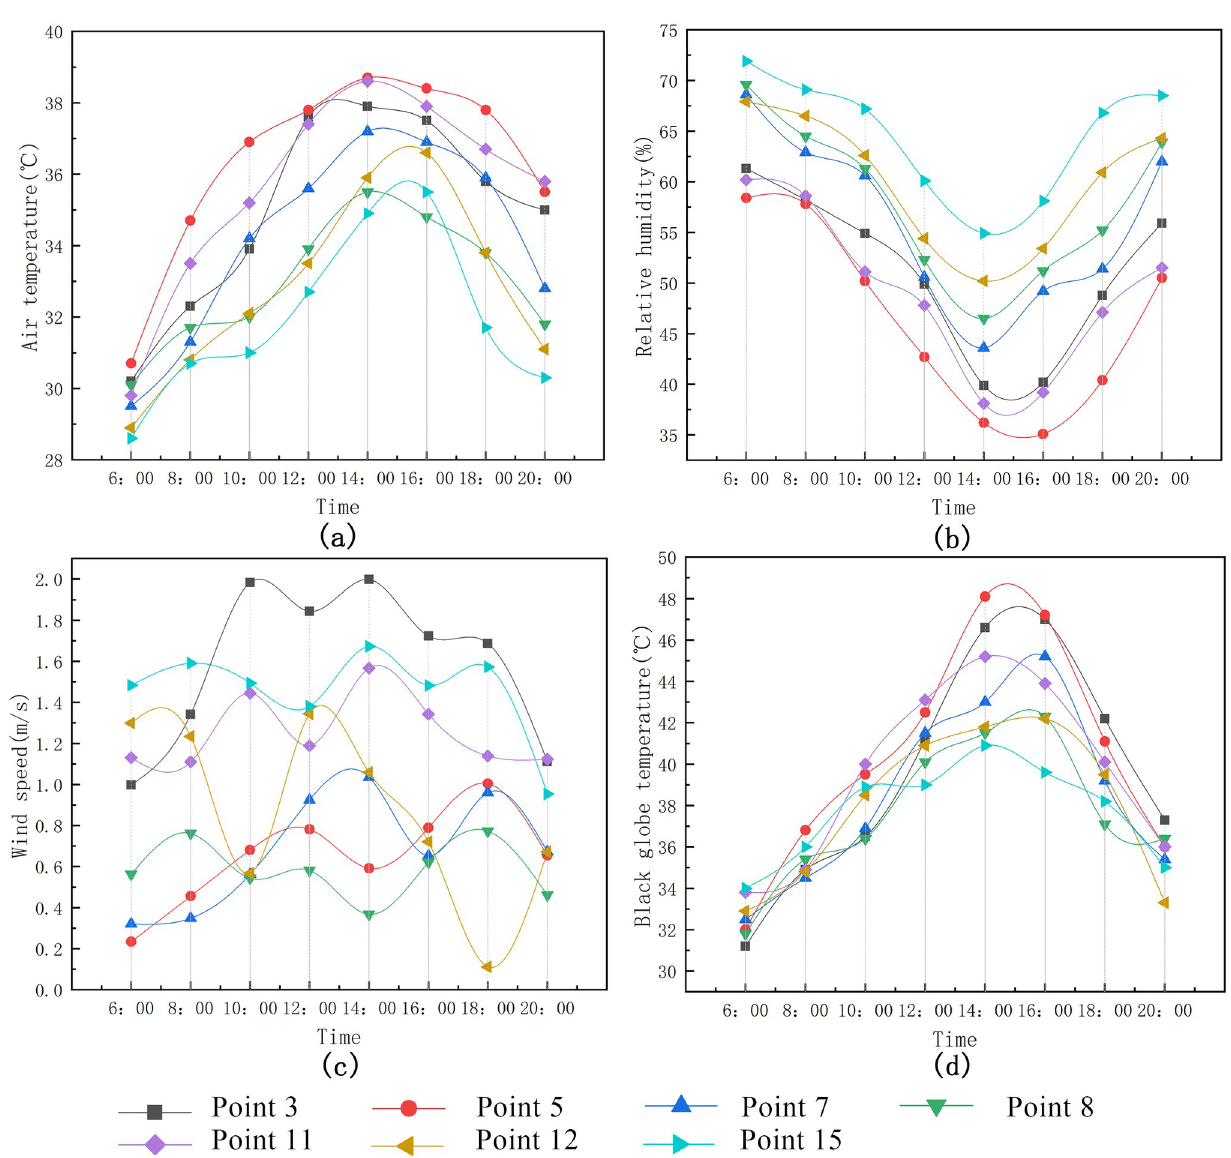
Fig 13. Variation trend of microclimate parameters at each measurement point in the street.